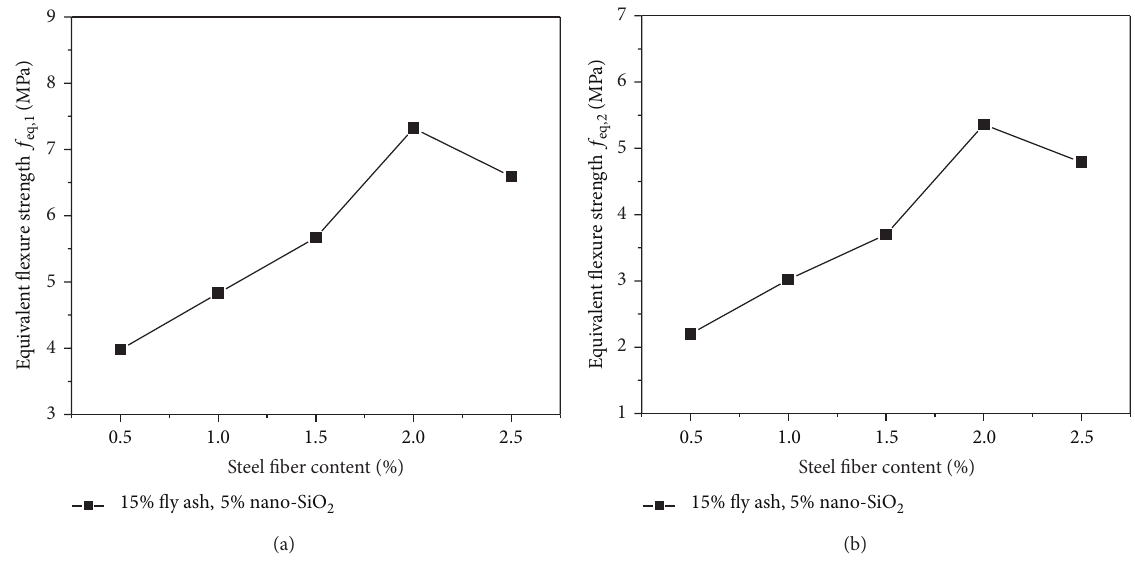
Figure 10: Effect of steel fiber content on equivalent flexure